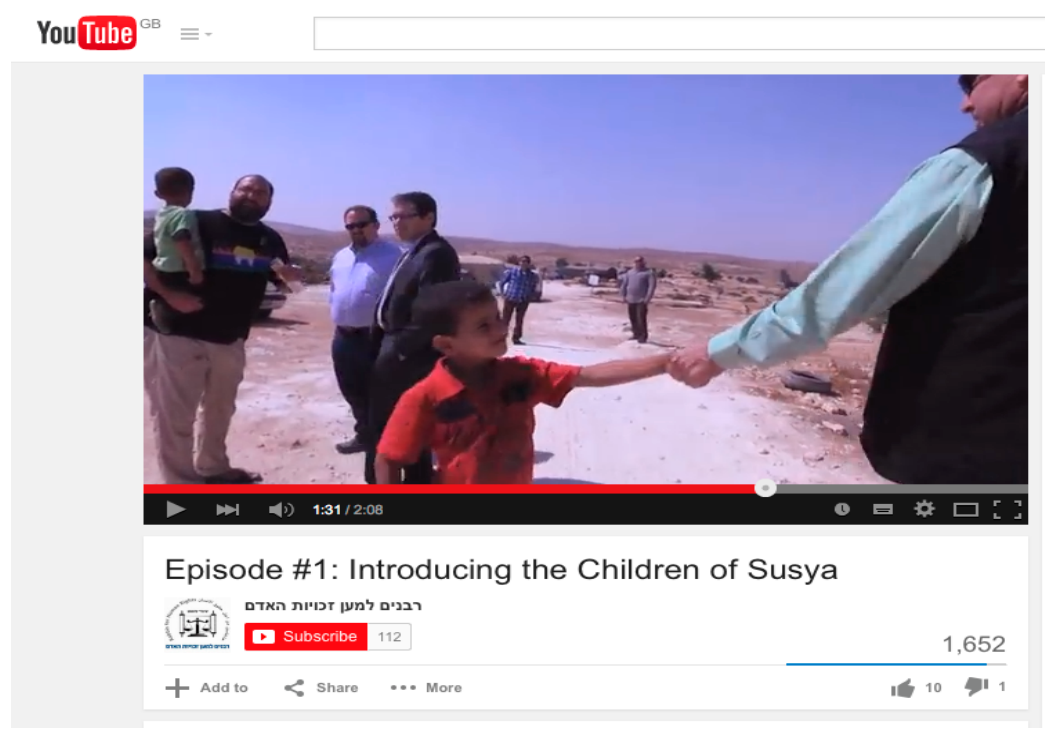
Figure 17. Screen grab from RHR’s YouTube video entitled ‘Introducing the Children of Susiya’. (Accessed on 17 October 2015).